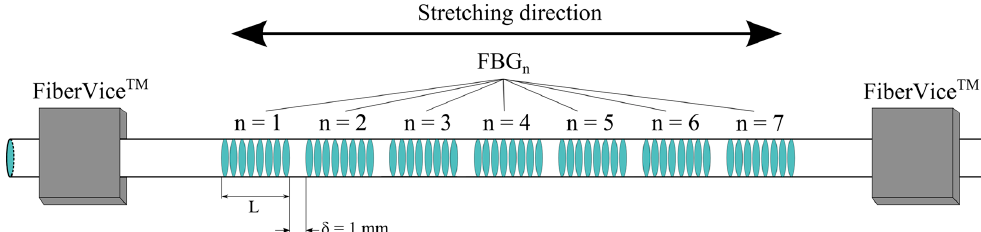
Figure 9. Experimental set-up for the strain testing of an array of FBGs.